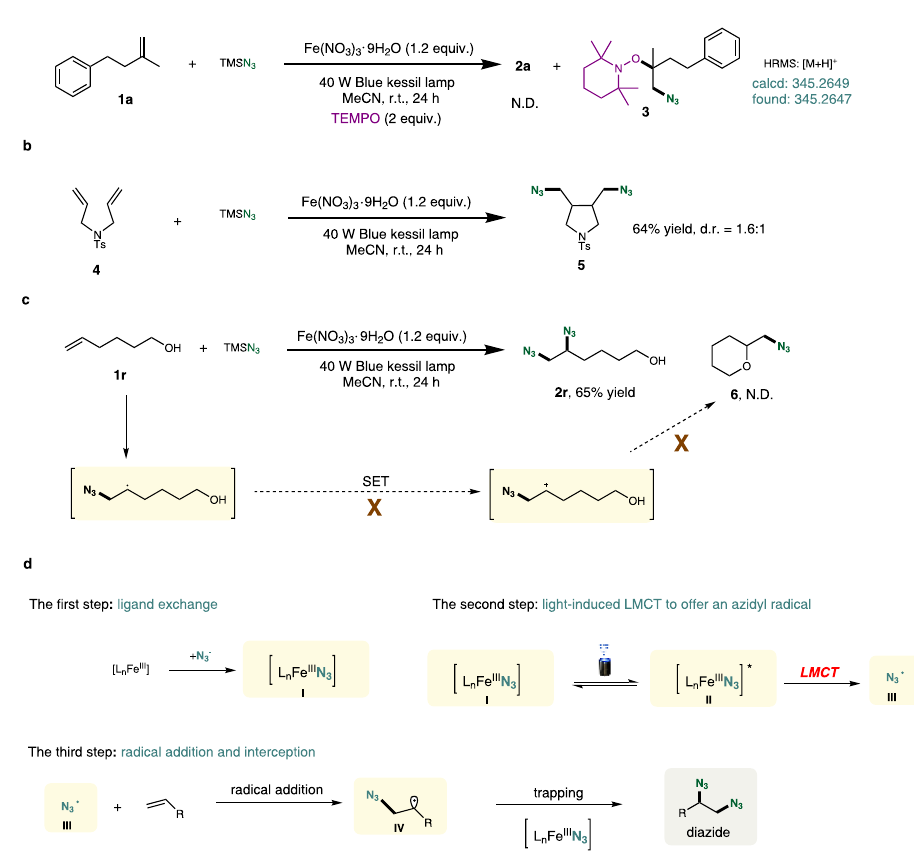
Fig. 3 | Mechanistic investigations and proposed reaction mechanism. a Radical trapping experiments. b Radical clock experiments. c Investigation of possible intermediates. d Plausible reaction mechanism. N.D. not